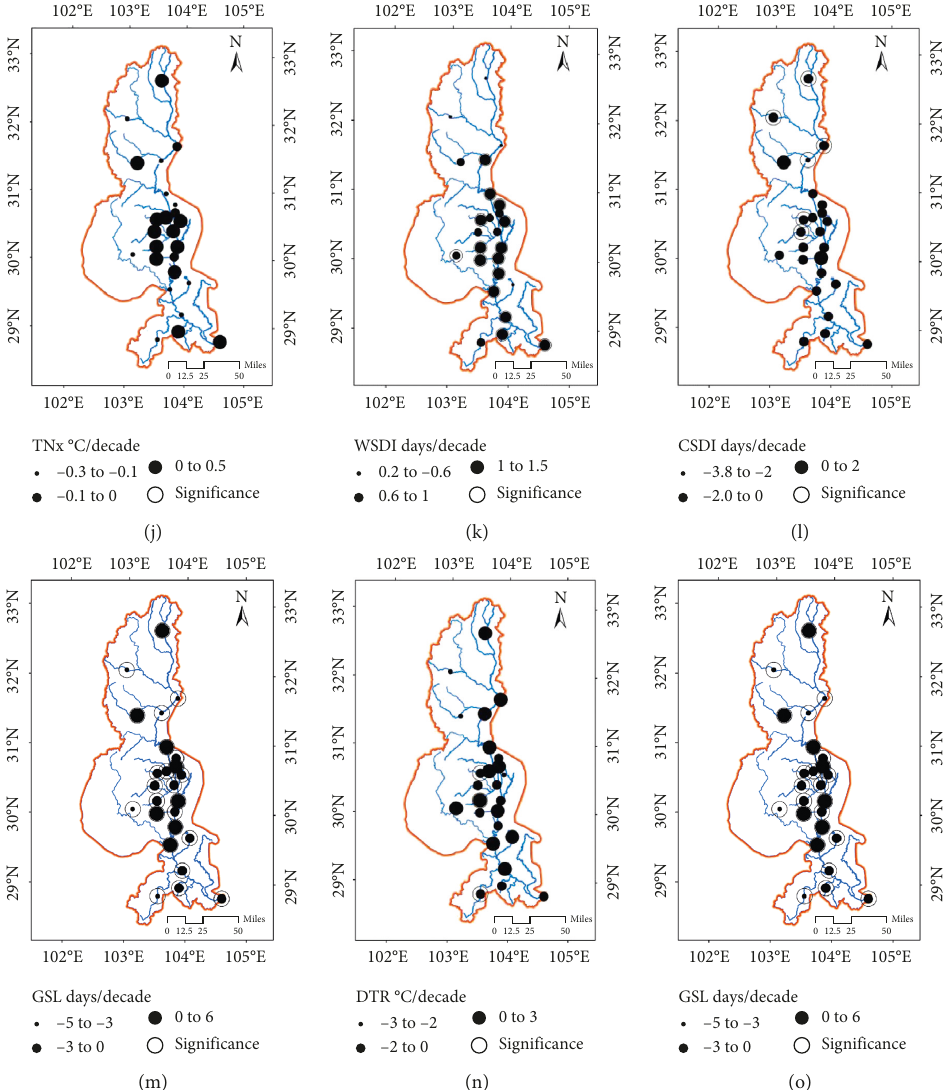
Figure 3: Spatial distribution of the extreme temperature variation trend in the Minjiang River Basin from 1961 to